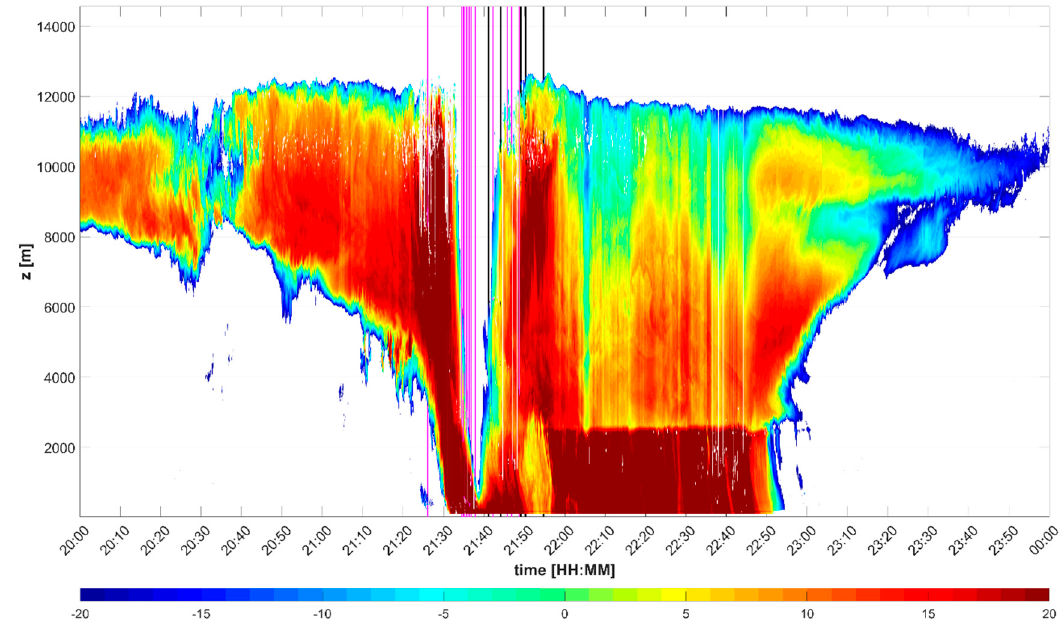
Figure 4. Temporal evolution of radar reflectivity factor (Z [dBZ]) of the cloud radar at the Milešovka observatory during the thunderstorm on 10 June 2019 from 20 to 24 h UTC. Vertical magenta lines depict CC near-lightning (NL) discharges, while vertical black lines display CG NL discharges. Note that y-axis (z [m]) displays the height in meters above the cloud radar situated at an elevation of 837 m